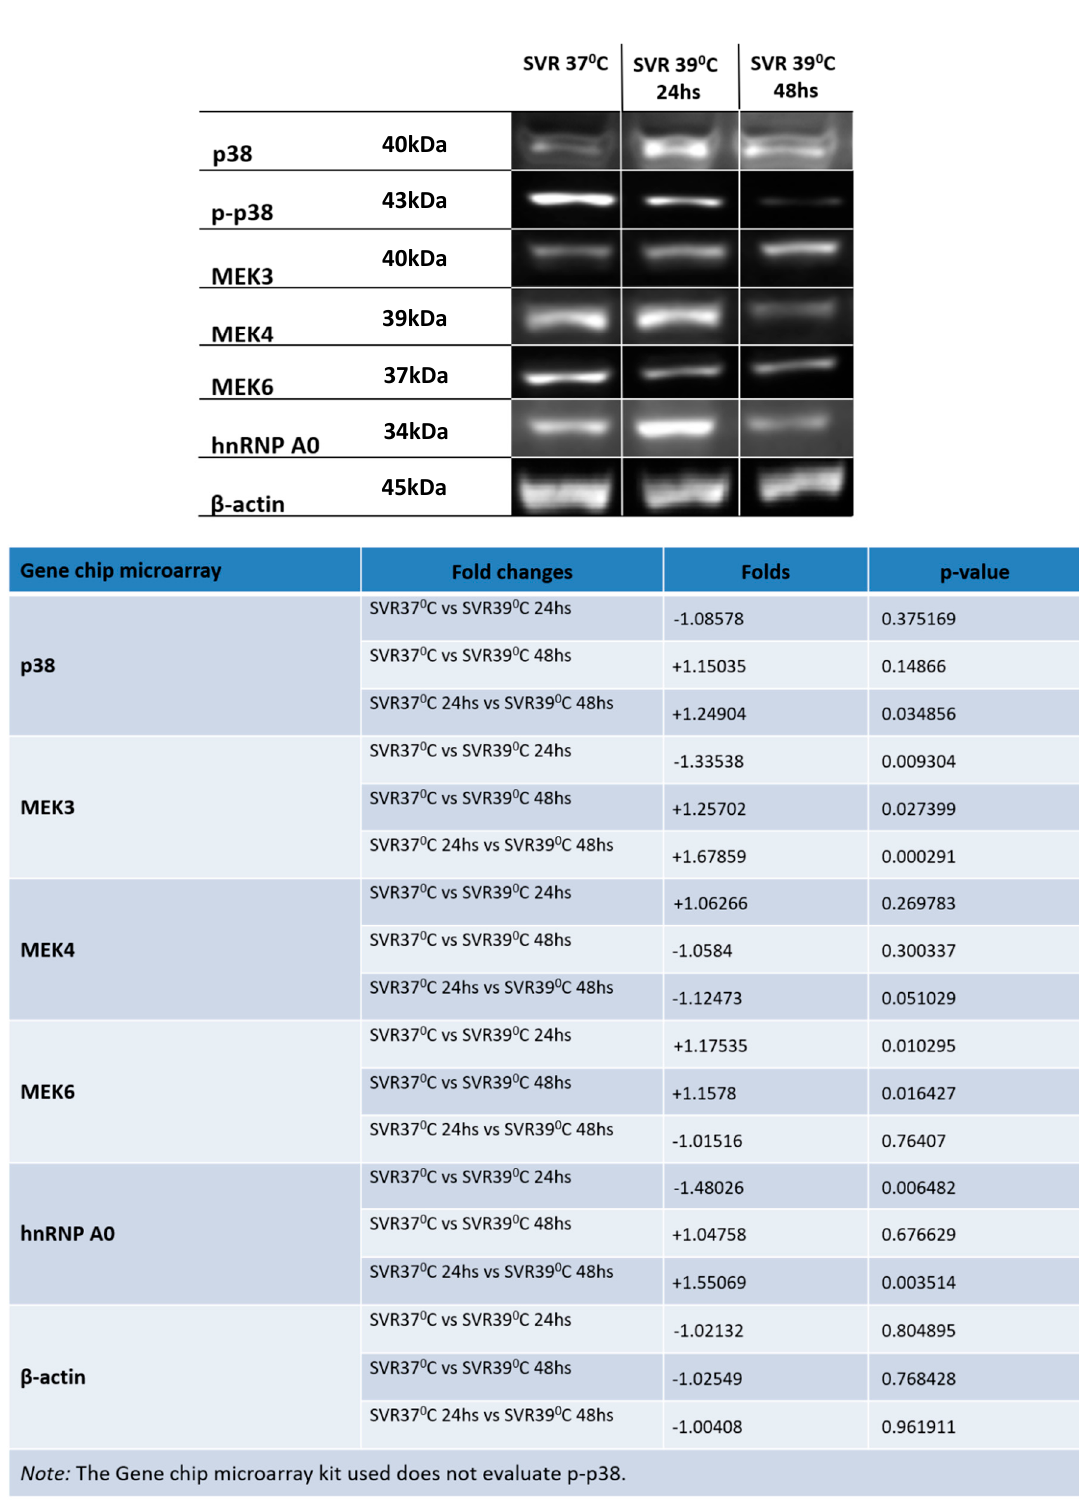
Figure 2. Western blot analysis conducted on SVR cells under 37 °C and 39 °C (in 24 and 48 h) for evaluating p38 and MAPK kinase kinase. Experiments were repeated in triplicate and p -values are displayed at the lower right panel.